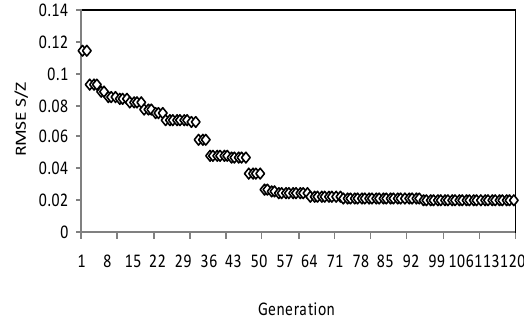
Figure 11. Root mean square error versus generation of s/z .